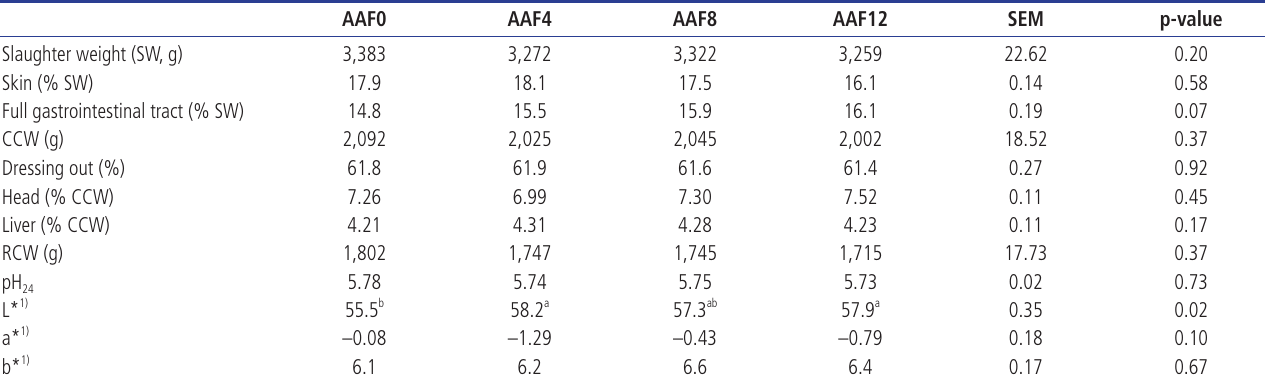
Table 4. Effect of increasing level of alfalfa flavonoids extract (AAF) on carcass characteristics and Longissimus dorsi muscle traits of growing rabbits (n = 12)